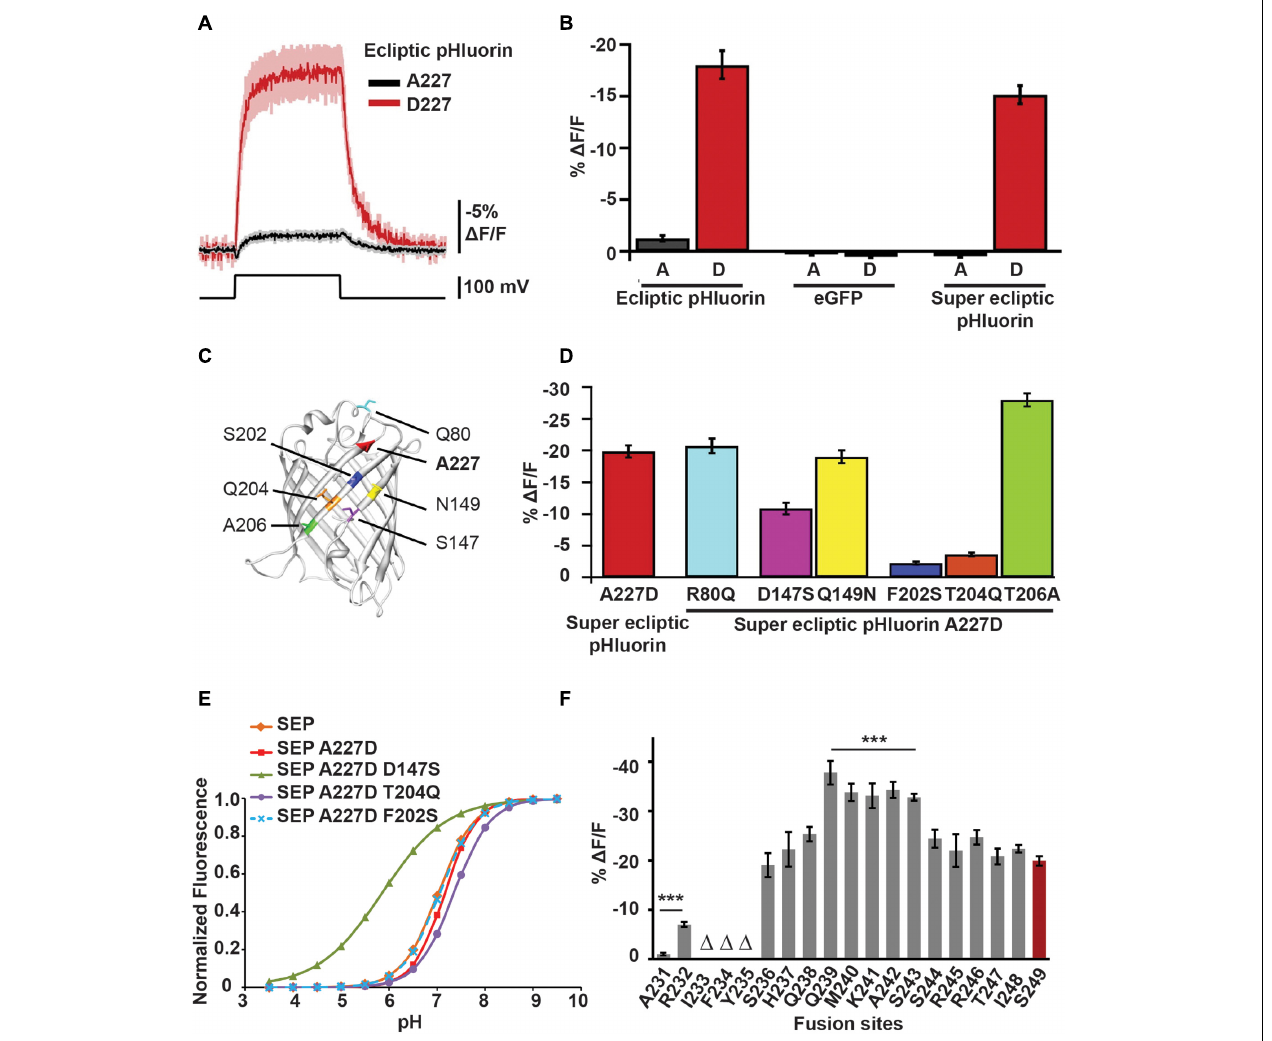
FIGURE 3 | Mutations in the FP sequence as well changes to the Ci VSD-FP linker length contribute to ArcLight’s voltage sensitivity. (A) Fluorescence responses to 100 mV depolarization of HEK cells transfected with Ci VSD-ecliptic pHluorin or Ci VSD-ecliptic pHluorin A227D. (B) 100 mV step responses (mean ± SEM) of HEK cells expressing 227A or 227D variants of each of Ci VSD-ecliptic pHluorin, Ci VSD-eGFP or Ci VSD-SEP. (C) Crystal structure of eGFP (PDB ID 1EMG) highlighting A227 as well as the six most dissimilar residues between SEP and eGFP. The SEP versions are indicated. Note that all four critical residues 147, 227, 202, and 204 reside on the same barrel surface of the fluorophore. (D) Fluorescence responses (mean ± SEM) of Ci VSD-SEP variants harboring mutations at indicated residues in (C) . These mutations serve to replace the SEP amino acids with corresponding residues found in eGFP. (E) pH sensitivity curves of SEP and SEP mutants containing eGFP residues at indicated sites. (F) Mean response amplitudes to 100 mV depolarization of ArcLight derivatives with modified linker length. Groups that significantly differ from ArcLight S249 are indicated with asterisks. (cid:49) refers to sensors showing poor membrane localization (Jin et al., 2012; Han et al.,